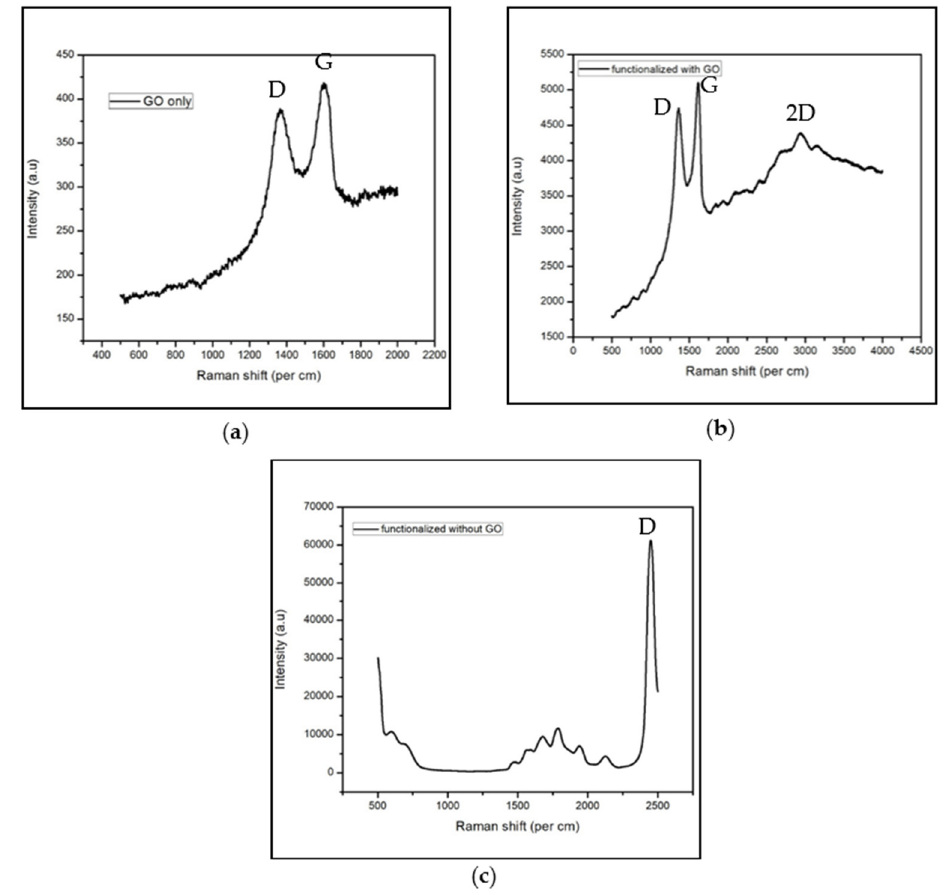
Figure 3. Raman spectrometry measurements on the cortisol biosensors functionalized with ( a ) only graphene oxide, ( b ) both graphene oxide and antibodies, and ( c ) only antibodies.